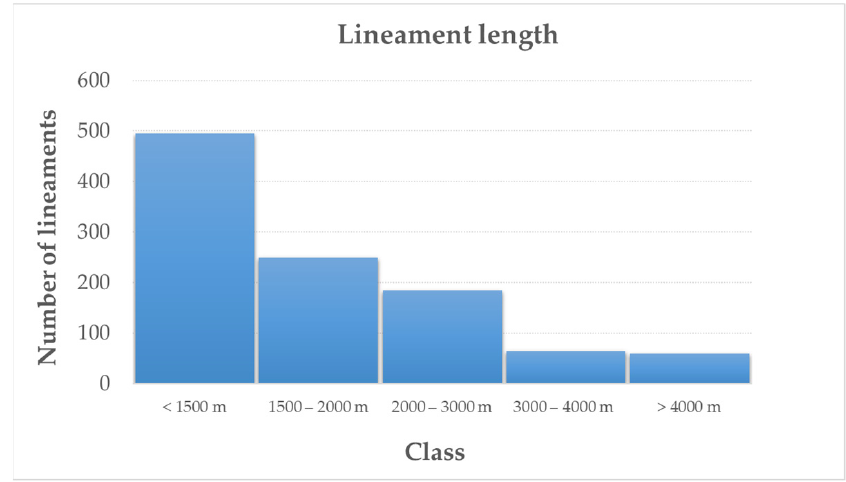
Figure 10 . Lineament length histogram .